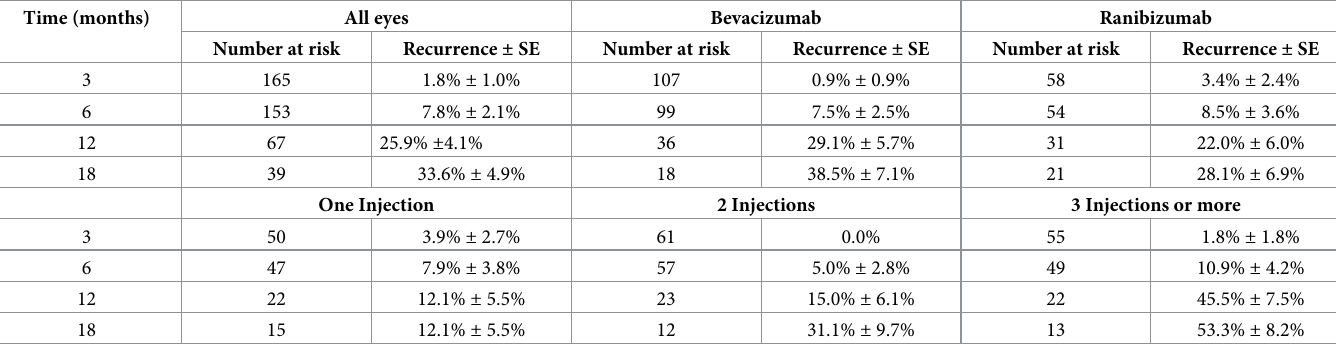
Table 2. Shows Kaplan Meier Survival table analysis overall, anti-VEGF, and number of injections